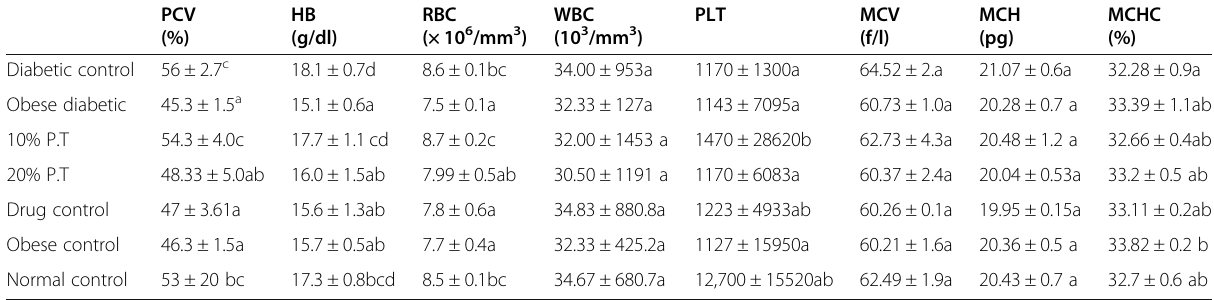
Results are expressed as mean±SD, n =5. Mean with the same alphabet within a column are not significantly different at P<0.05 using Duncan multiple range test for separation of statistically significant means. P.t (Pleurotus tuber-regium) PCV(Packed cell volume), HB (haemoglobin), RBC (Red blood cel) l, WBC (White blood cell), PLT (Platelet), MCV (Mean Corpuscular Volume), MCH (Mean Corpuscular Haemoglobin), MCHC (Mean Corpuscular Haemoglobin